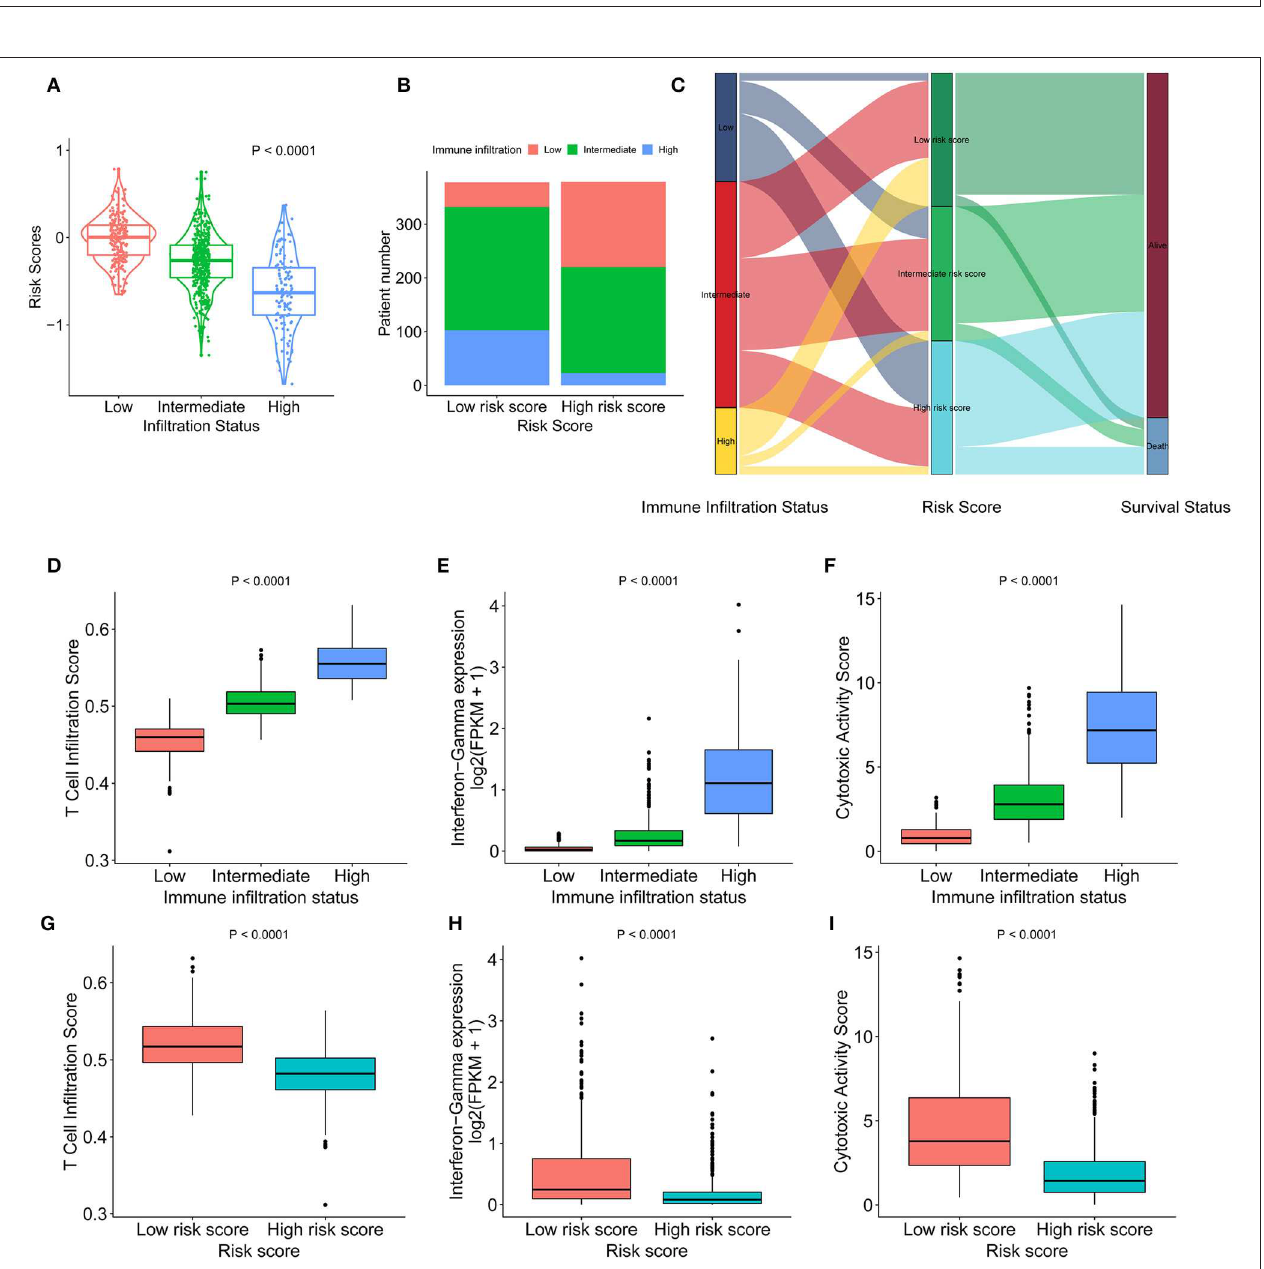
FIGURE 3 | Heterogeneous immune cell infiltration in the low- and high-risk score groups. (A) The distribution of risk scores in low, mediate, and high immune infiltration patterns. (B) The distribution of immune infiltration patterns in the low- and high-risk score groups. (C) Alluvial diagram of immune infiltration patterns in groups with different risk scores and survival outcomes. (D) TIS in low, mediate, and high immune infiltration patterns. (E) Relative interferon- γ signature in low, mediate, and high immune infiltration patterns. (F) Comparison of relative CYT in low, mediate, and high immune infiltration patterns. (G) Relative TIS in the low- and high-risk score groups. (H) Relative interferon- γ signature in the low- and high-risk score groups. (I) Comparison of relative CYT in the low- and high-risk score groups. TIS, T cell infiltration score; CYT, cytotoxic activity scores.